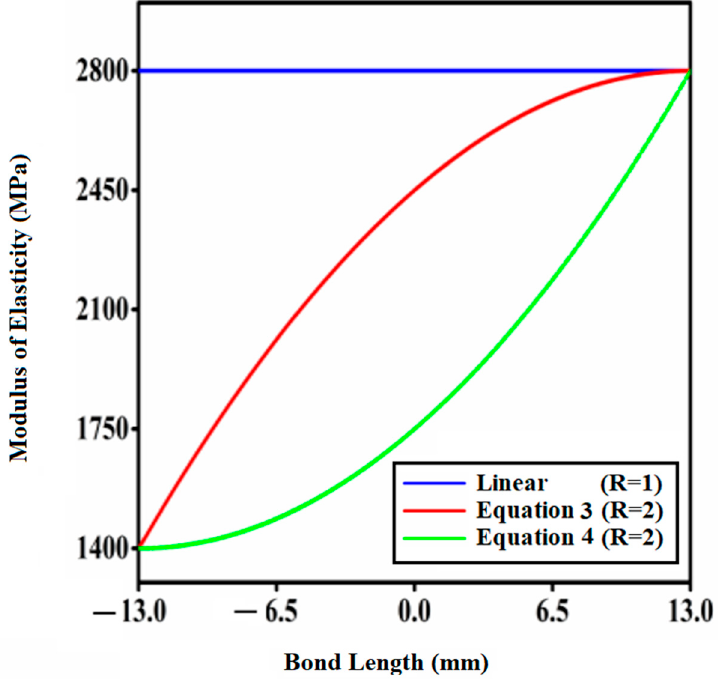
Figure 5. Asymmetric fluctuation of the adhesive thickness’s elastic modulus (E) along the modulus ratio R = 2 (Equations (3) and (4)).